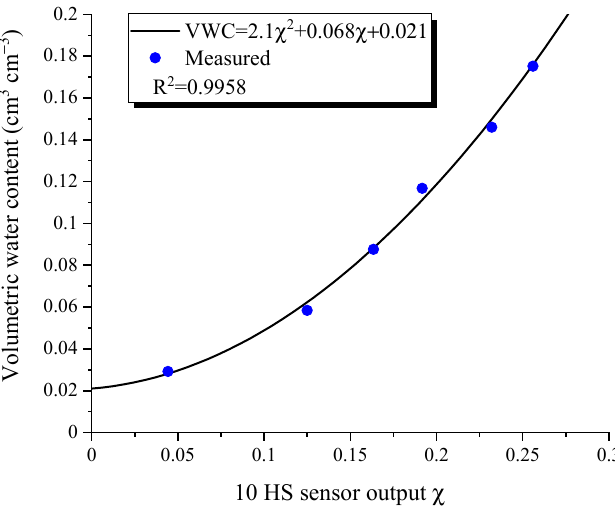
Figure 5. Calibration function for 10 HS sensor in sandy soil in experiment plot.